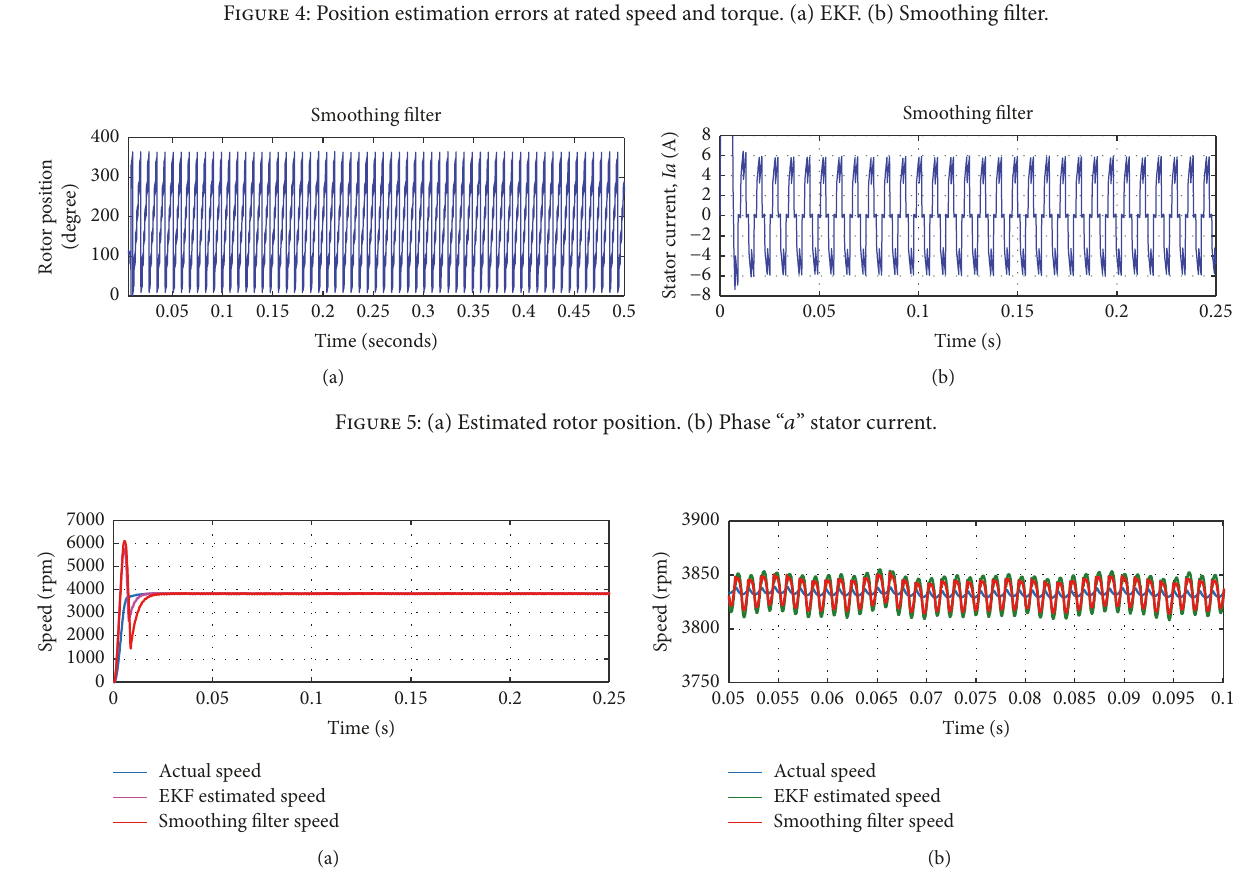
Figure 4: Position estimation errors at rated speed and torque. (a) EKF. (b) Smoothing filter.